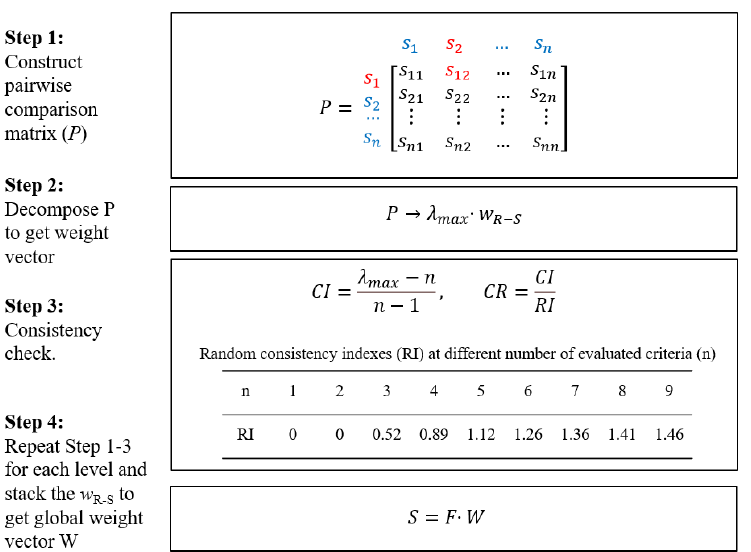
Figure 2. Framework to quantify the importance of influential factors with analytical hierarchy process (AHP) method. s i is the i-th factor candidate to the goal, and s ij denotes the relative importance of factor i to j according to Table 2. λ max and w R-S are the maximum eigenvalue and corresponding eigenvector, respectively. S is a single value indicator from dot products of input vector F and global weight vector W .